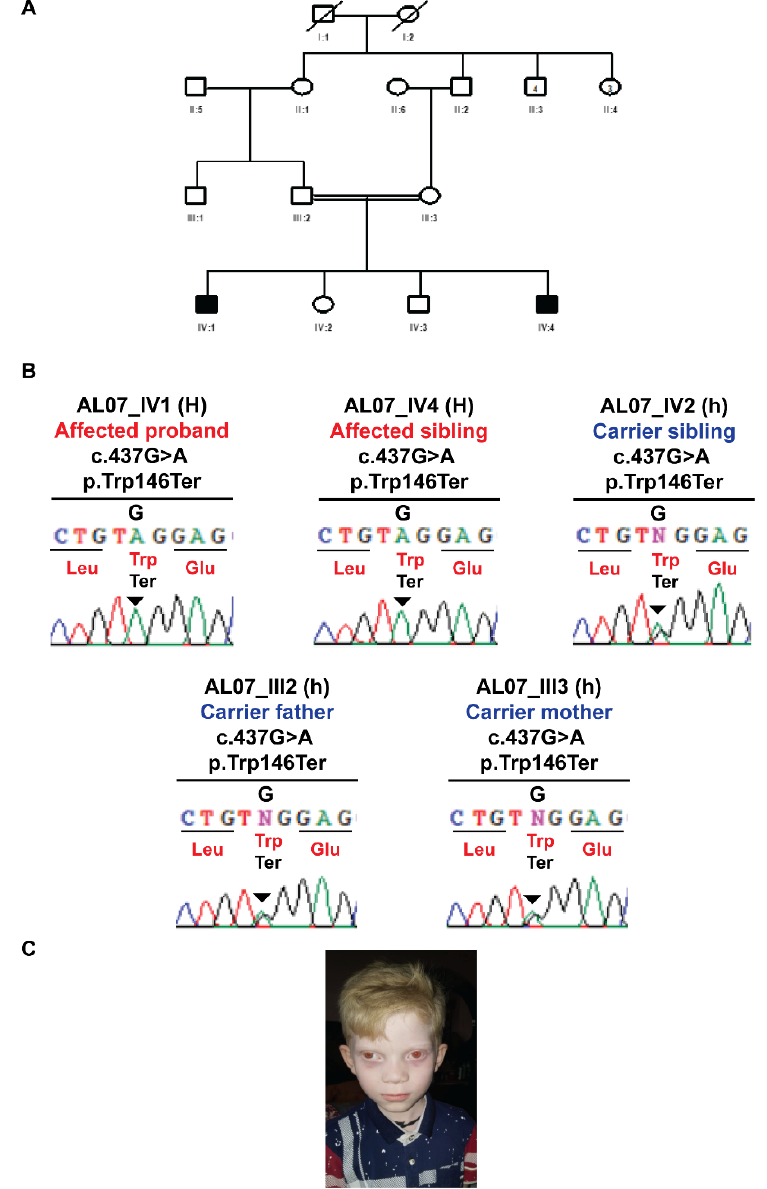
Figure 3. Homozygous nonsense HPS1 p.Trp146Ter variant in AL07 family manifesting albinism. ( A ) Pedigree structure of AL07 family. ( B ) Sanger sequencing electropherograms reflecting the familial segregation of HPS1 p.Trp146Ter novel pathogenic variant in AL07 family. ( C ) Clinical image depicting clinical features of albinism in pro-band IV-1 of family AL07.